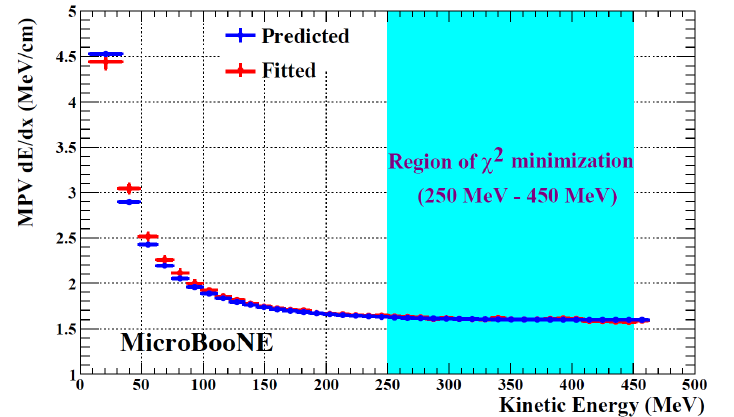
Figure 5. Energy deposited (dE/dx) as a function of the cosmic ray muon’s kinetic energy for the collection plane calorimetry. The red represents data from 2016 with the best fit of the gain value, and the blue represents the expectation from [28]. The figure was originally seen in